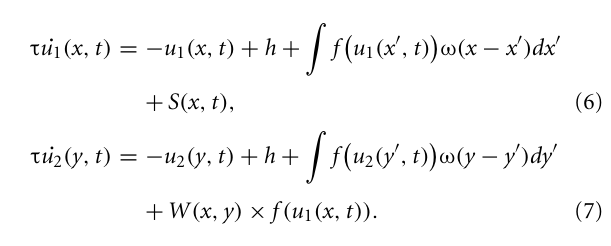
DNF. The perceptual DNF enhances the perceptual input in a selected region (which reached the activation threshold first), and inhibits all other locations in the visual array, performing an elementary object segregation